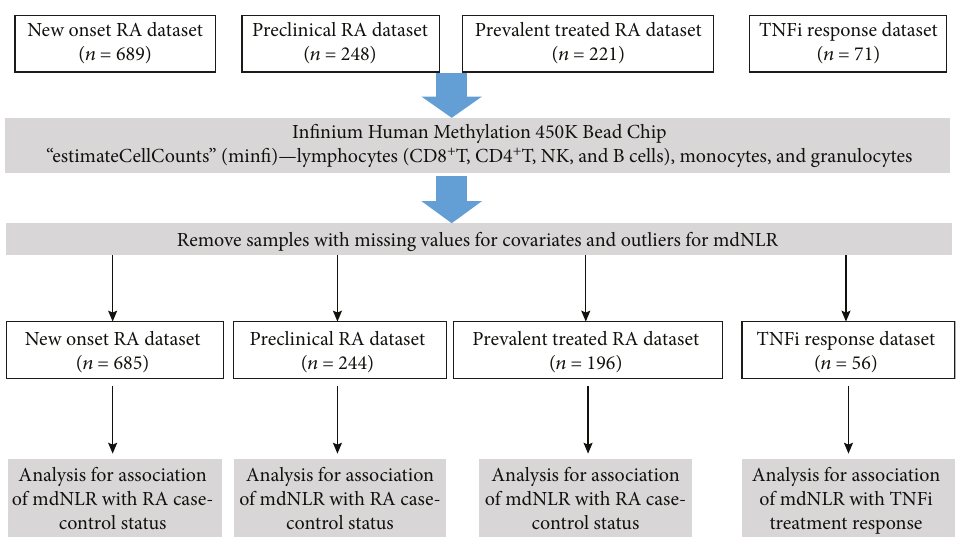
Figure 1: An overview of the study